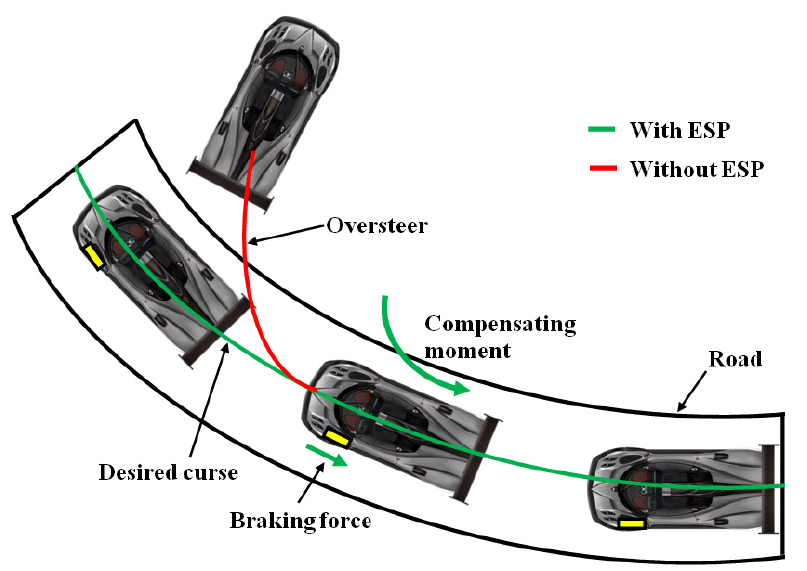
Figure 18. Effect on the vehicle stability achieved with an ESP system.